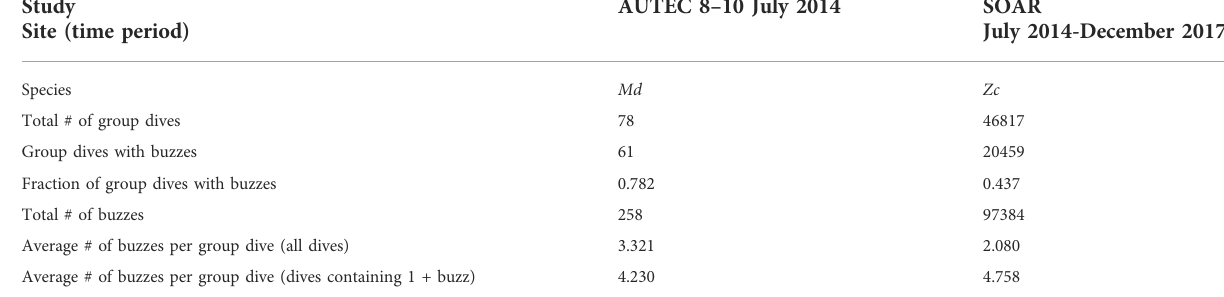
TABLE 3 Summary of buzz detection at AUTEC and SOAR.